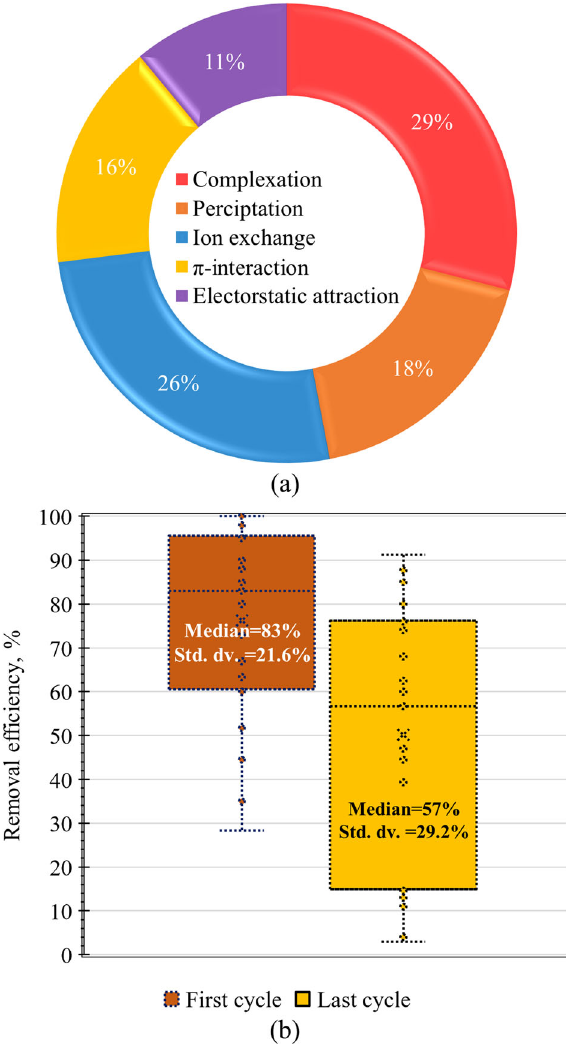
Fig. 4 Summary of heavy metal adsorption ’ s dominant removal mechanisms and regeneration ef fi ciencies. a The surface com- plexation is the dominant adsorption mechanism, followed by ion exchange. b The last cycle ef fi ciency regeneration has a wide range, indicating the instability of the regeneration of heavy metals. Note that the vertical lines present the deviation from the median value.